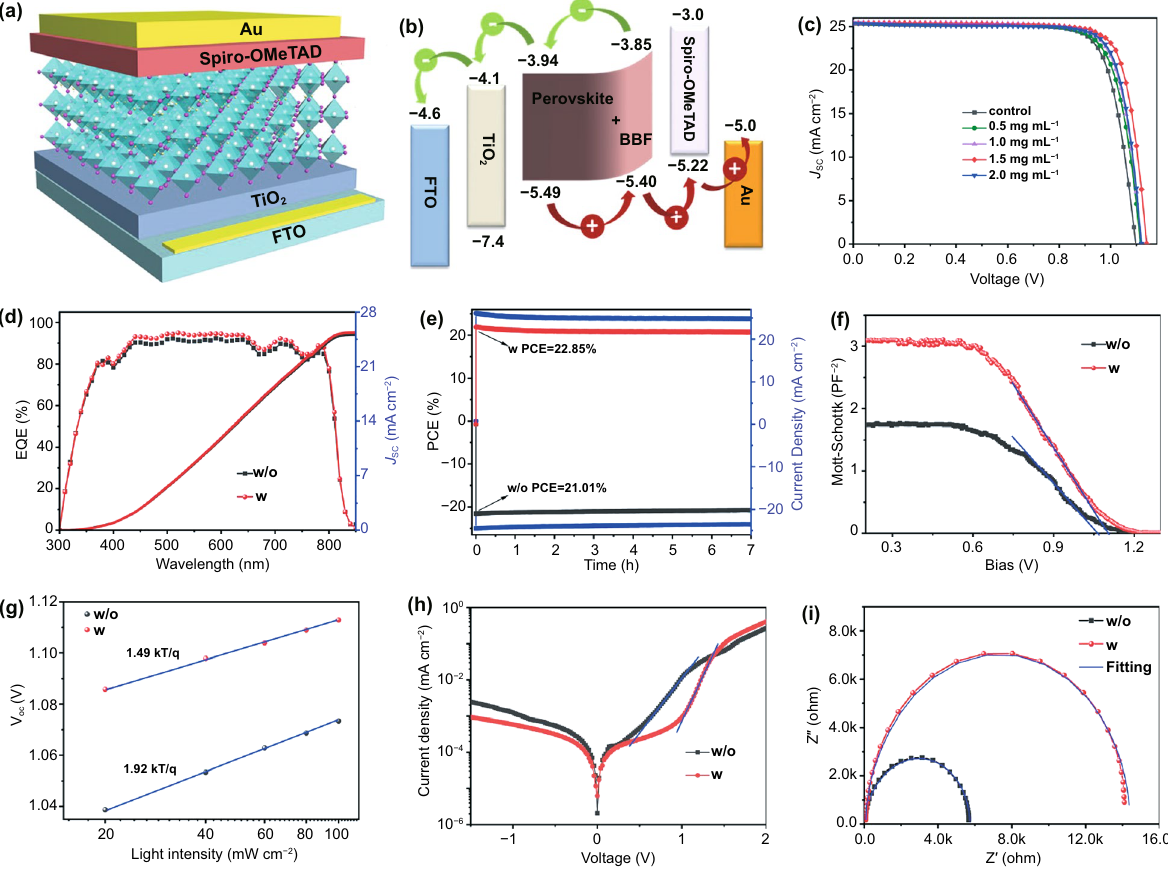
Fig. 6 a Schematic image of the hybrid PSC device with the structure FTO/TiO 2 /perovskite/Spiro-OMeTAD/Au. b Schematic energy-level alignment of the hybrid PSCs with BBF additive. c J-V curves of the hybrid PSCs with different concentrations of BBF additive. d EQE spec- tra. e stable output. f Mott-Schottky plots. g V OC dependence on light intensity. h dark current–voltage characteristic and i Nyquist plots of the hybrid PSCs with and without BBF